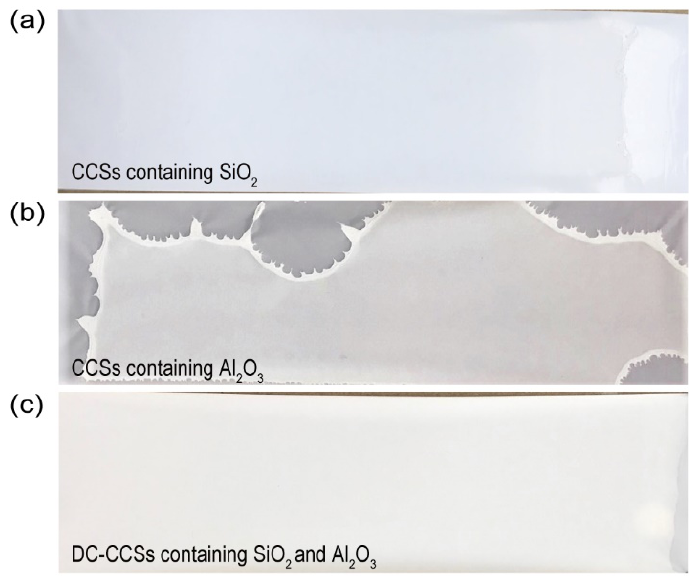
Figure 3. Digital camera images of CCSs containing ( a ) SiO 2 , ( b ) Al 2 O 3 , and ( c ) DC-CCSs containing SiO 2 and Al 2 O 3 (width of separator = 6 cm).